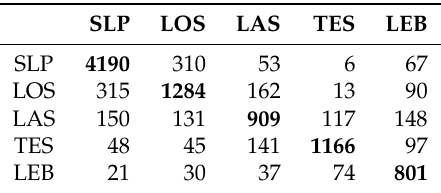
Figure 16. Comparison result of recognition accuracy in each behavior pattern. Table 10. Confusion